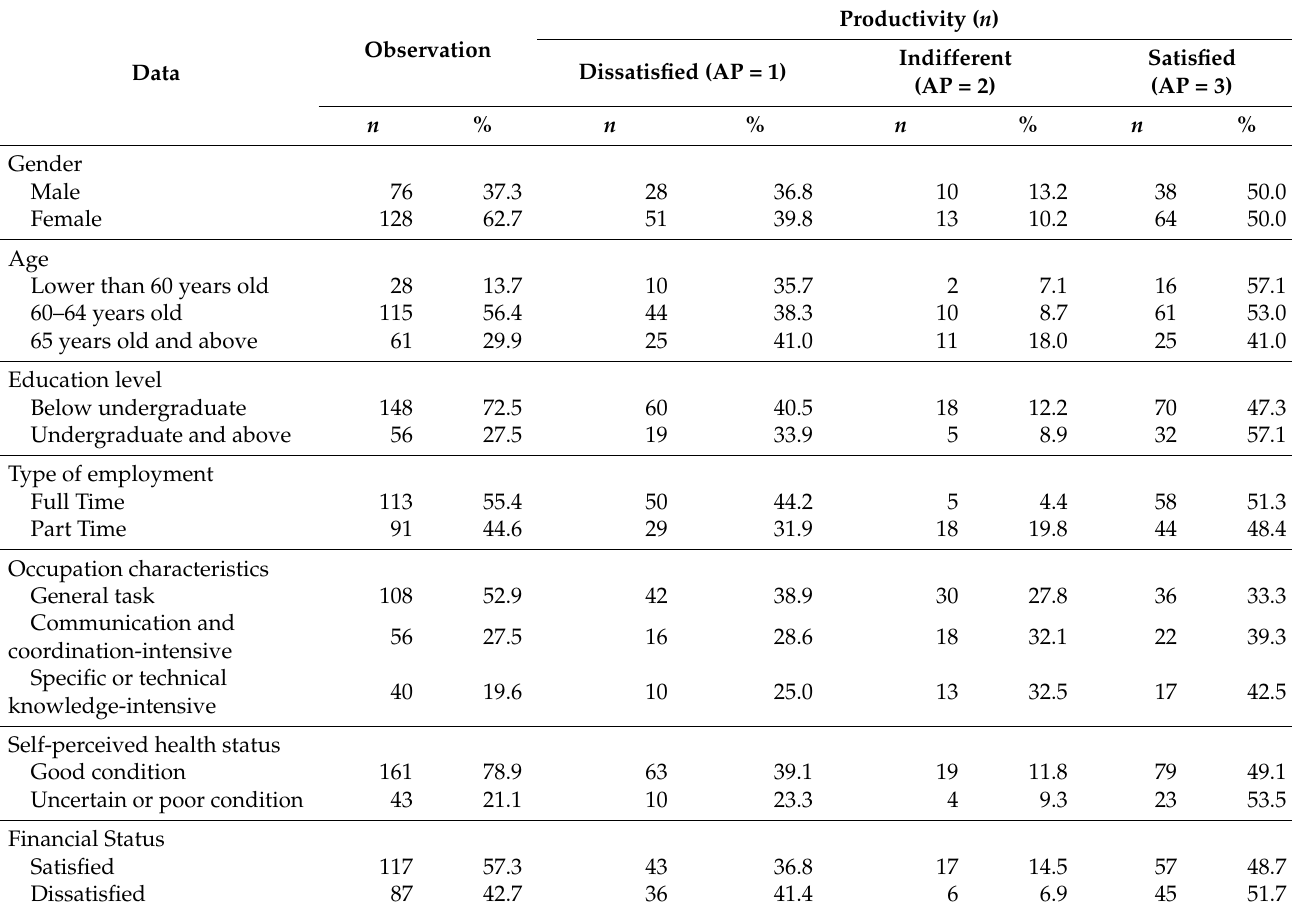
Table 2. Used data